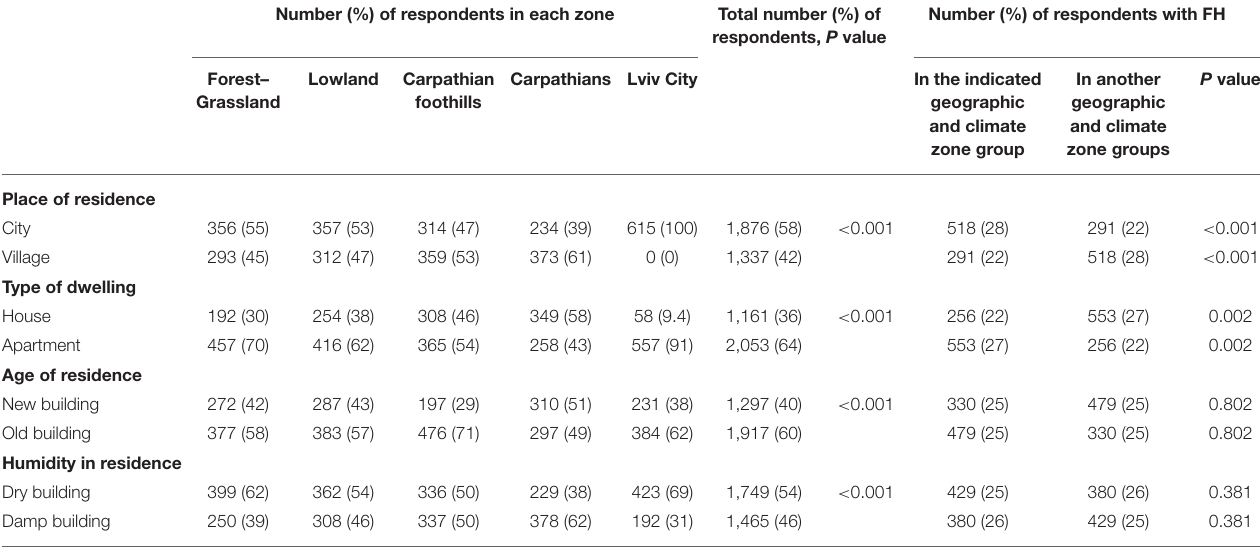
TABLE 7 | Comparison of living conditions of children from different geographic and climate zones * . Number (%) of respondents in each zone